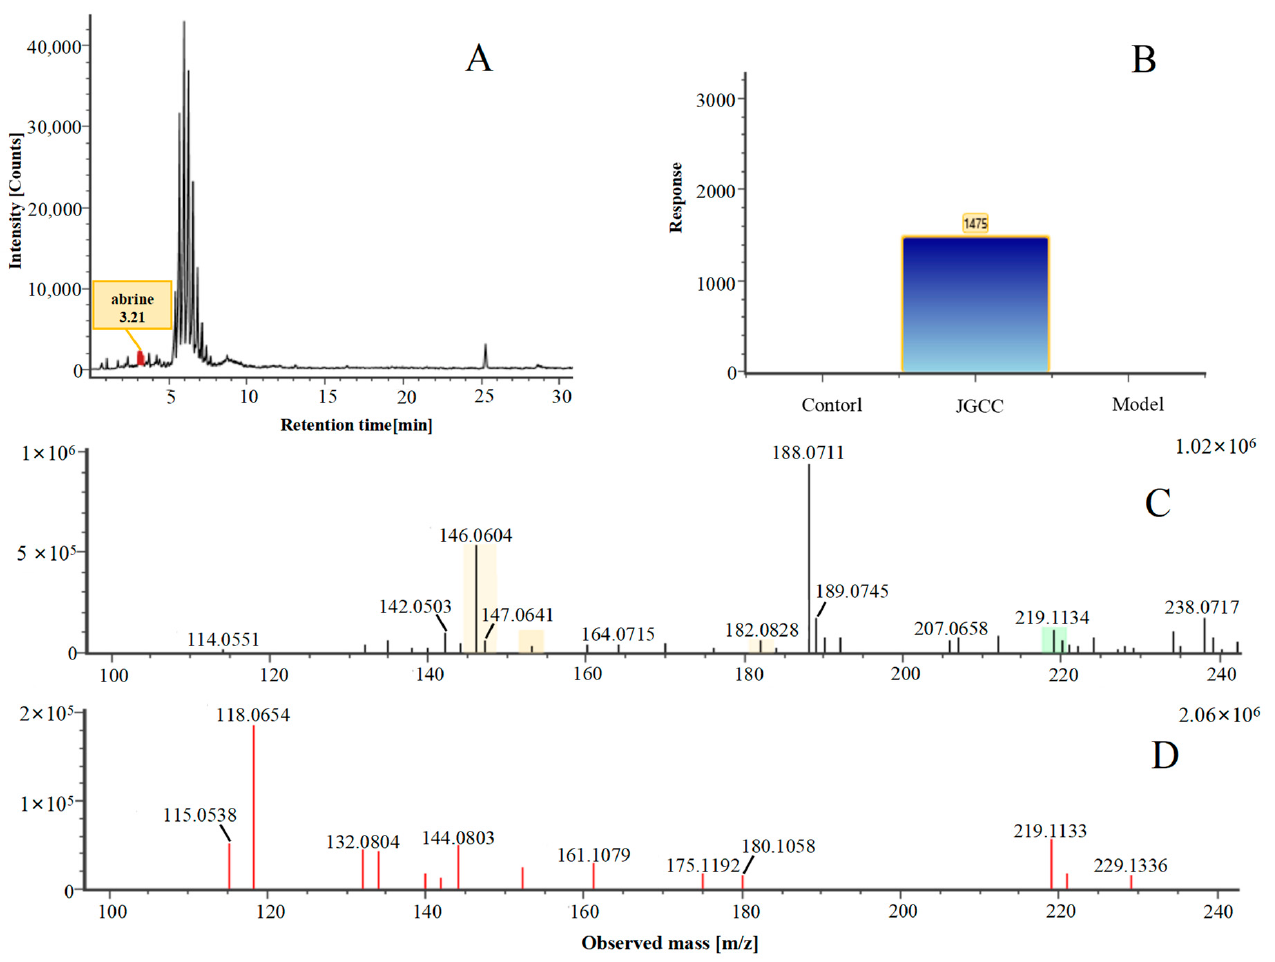
Figure 4. The characterization and identification process of abrine, the prototype component of JGCC found in the blood, based on the UNIFI data processing platform. ( A ): extraction of chromatographic peaks of abrine. ( B ): comparison of response values of abrine in control group, model group and JGCC group after the ingredients entered into the blood. ( C ): MS/MS information of abrine under low-energy collision; ( D ): MS/MS information of abrine under high-energy collision.